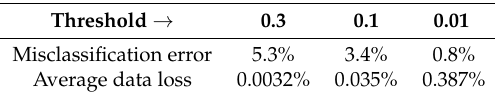
Table 7. Performance evaluation of k -NN trained on 500-bin histograms for device type classification for different values of data cleaning thresholds, and the corresponding data